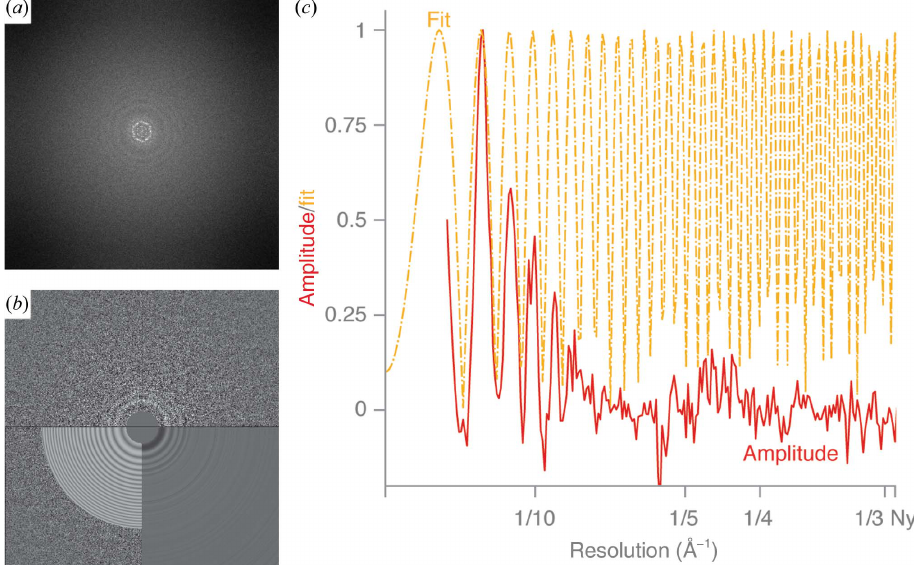
Figure 4 Contrast transfer function (CTF). ( a ) Fourier transform of a typical DPS micrograph. The form factor of the molecules and their close-packed ordering in the ice give the strong signals at low frequencies. ( b ) Fourier transform of the same DPS micrograph, with equiphase averaged Thon rings, and the corresponding CTF fit. ( c ) Background-subtracted amplitude spectrum (100 keV, (cid:2) 1 m m defocus, fitted in CTFFIND 4.1, scaled to have a value of 1 at the second peak) (solid red line) and the fit (yellow dashed and dotted